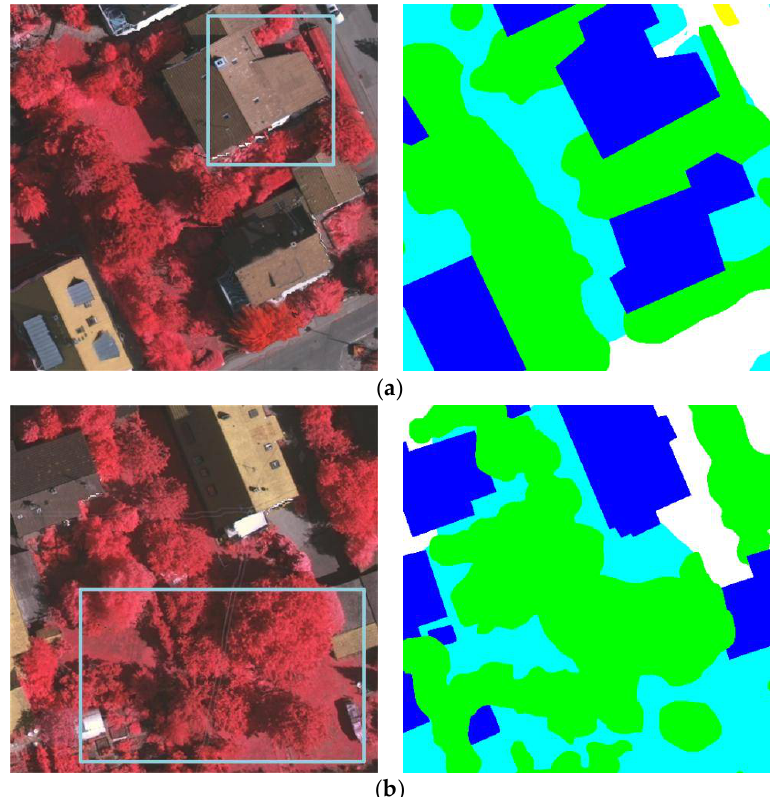
Figure 1. Examples of rich spatial information and complicated senses in high resolution remote sensing image: ( a ) objects (such as buildings) have rich edge information and details and ( b ) low vegetation and trees are similar in 2D appearance, but belong to two different labels.